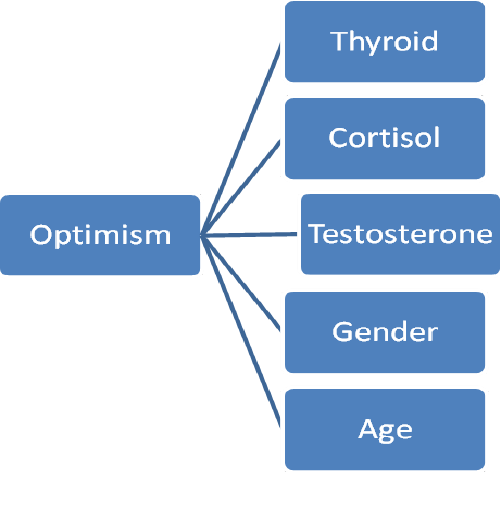
Figure 1. Conceptual